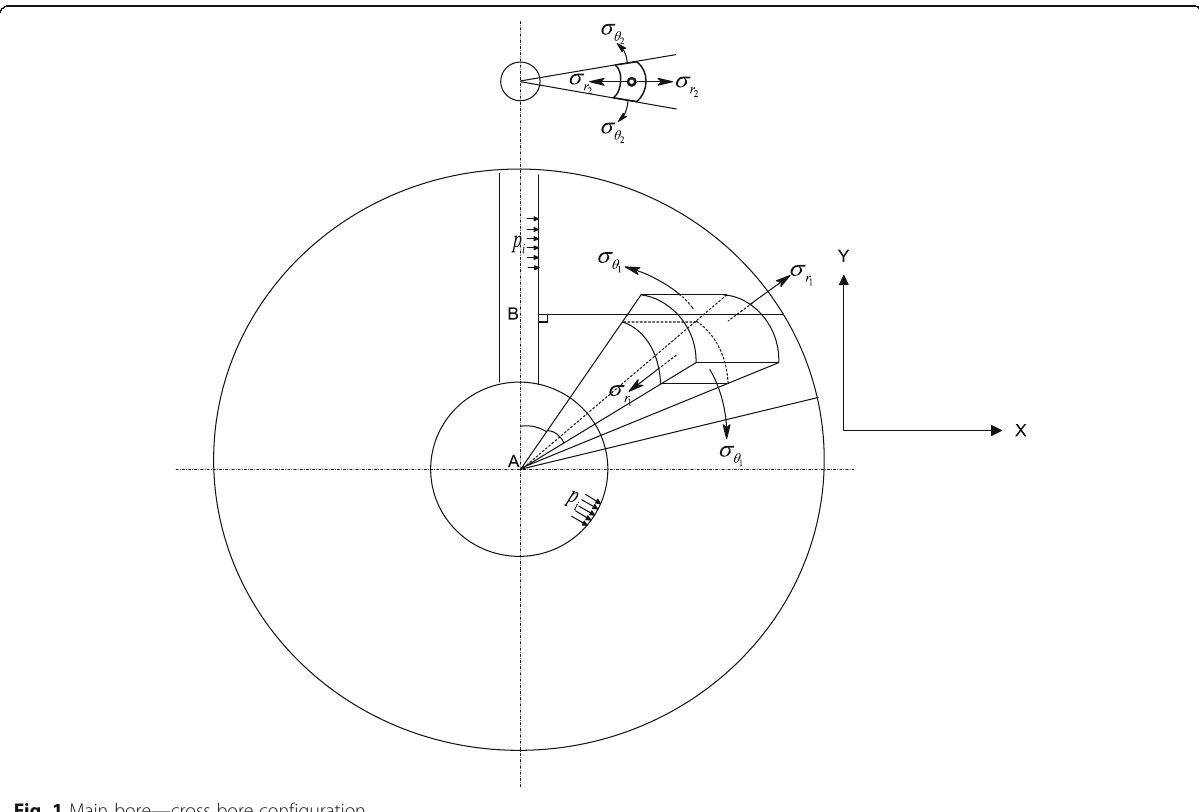
Fig. 1 Main bore — cross bore configuration